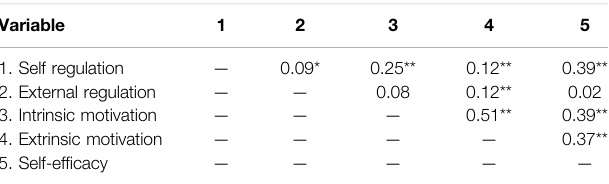
TABLE 4 | Correlation matrix for the variables self regulation, intrinsic motivation, and self-ef fi cacy on the follow-up.